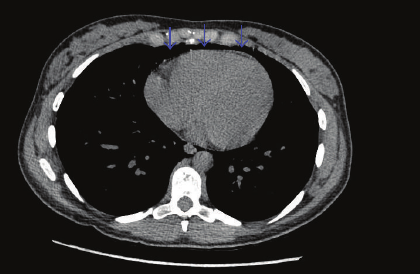
Figure 3: There is an evidence of pneumopericardium without evidence of right ventricular collapse (blue arrows).